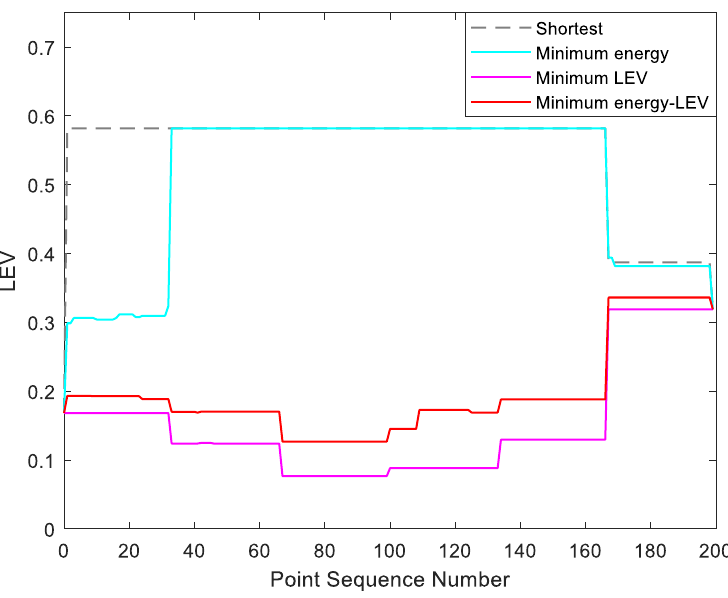
Figure 23. The LEV in the experiments. Table 7. Experimental results of trajectory